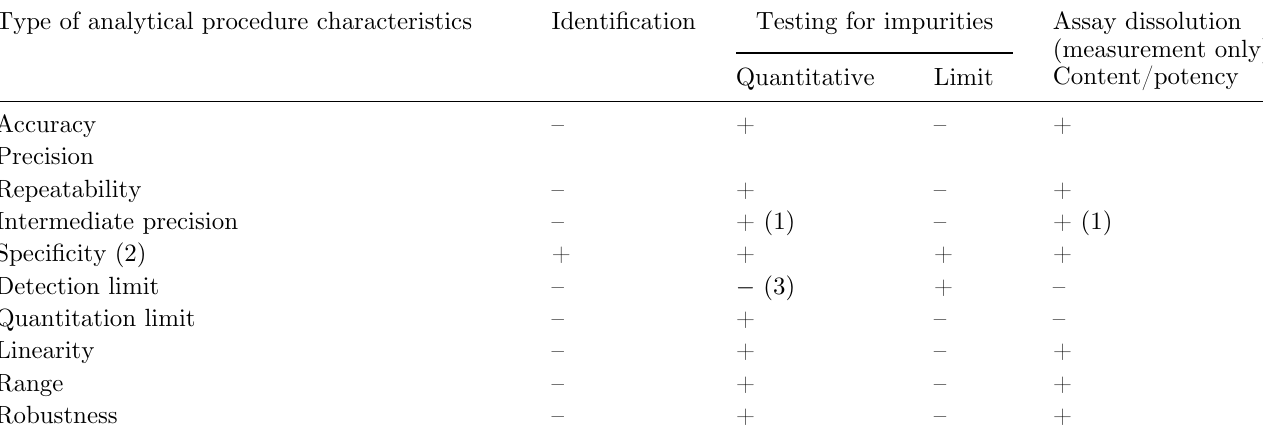
Table 2. Validation characteristics according to the nature of the